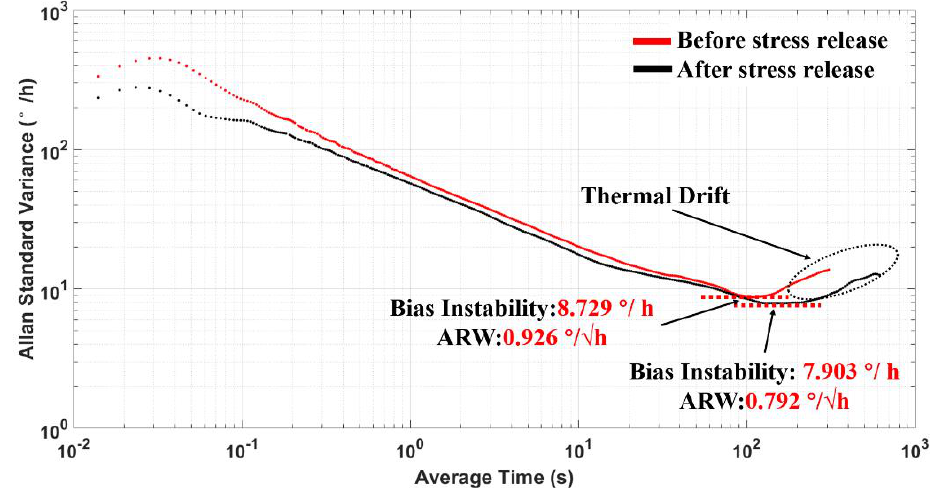
Figure 12. Allan standard variance plot.